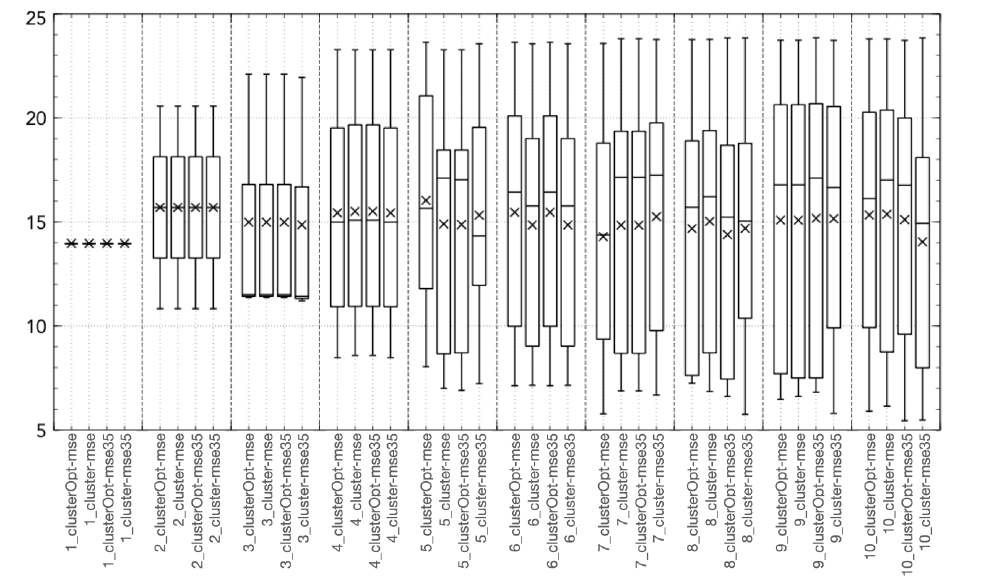
Figure 5. Boxplot of coordinate 3 ( u 2 ( t ) , daily mean temperature at time t ) of the centroid [ C ] .